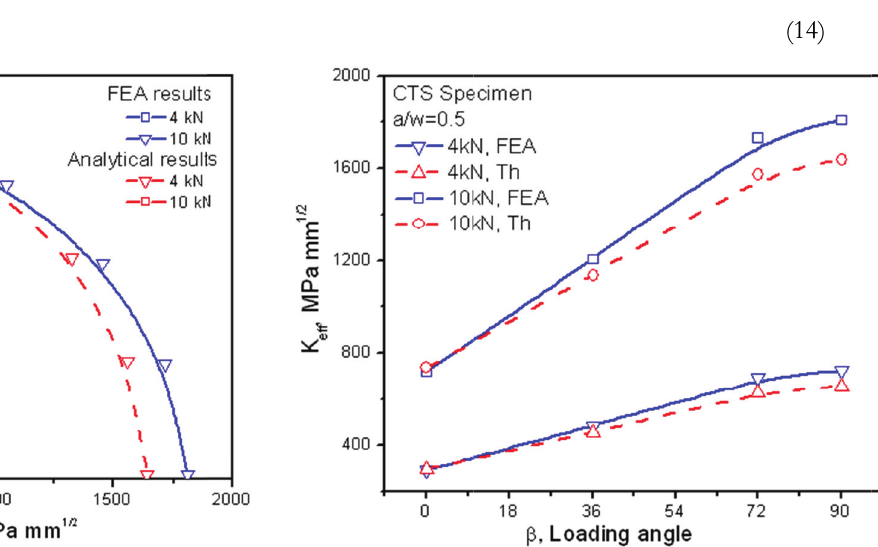
Figure 5: Vari he computed m for various a ults [9, 13].